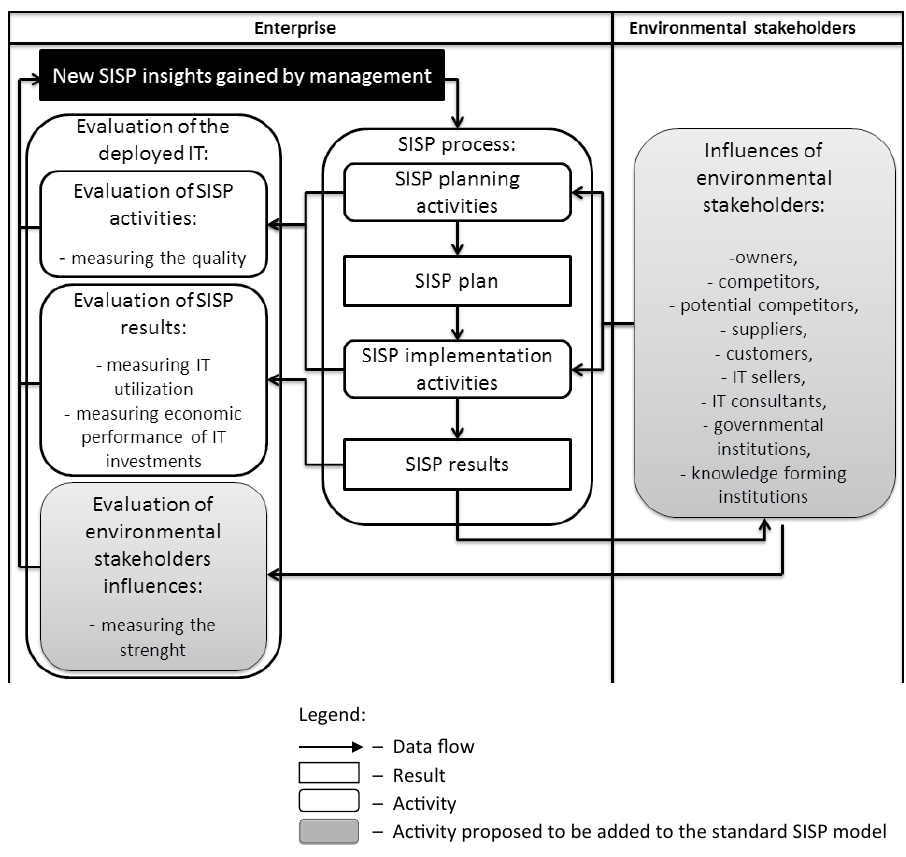
Fig. 1. The extended SISP